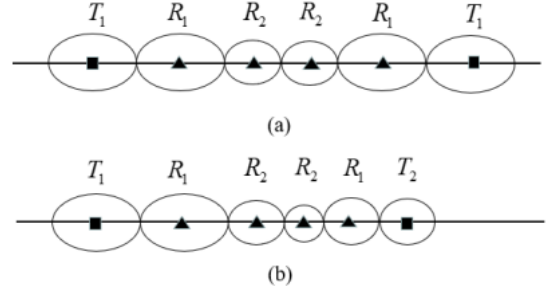
Figure 15. Di ff erences of basic placement sequence homogeneous / heterogeneous. ( a ) Homogeneous Figure 15. Differences of basic placement sequence homogeneous/heterogeneous. ( a ) Homogeneous basic placement sequences; ( b ) Heterogeneous basic placement basic placement sequences; ( b ) Heterogeneous basic placement sequences.